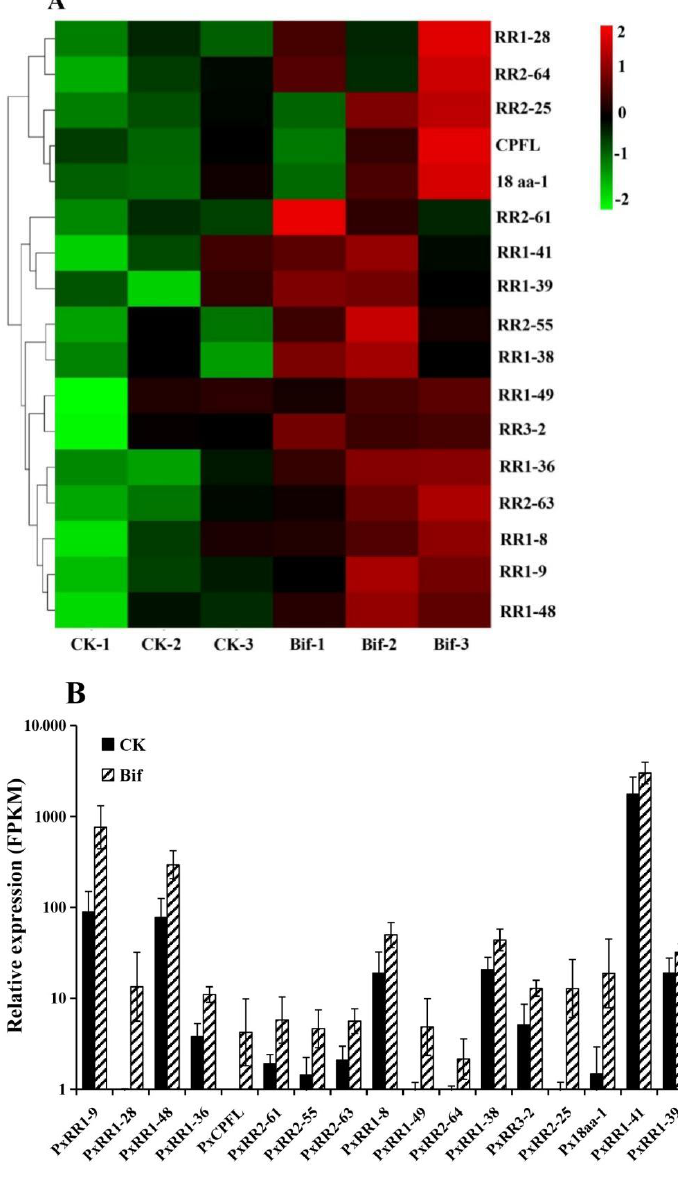
Figure 7. The expression levels (FPKM value) of 17 cuticular protein (CP) genes in Plutella xylostella treated with bifenazate at concentrations of LC 30 . ( A ) Heatmap of 17 CPs expression levels. X -axis: sample name, Y -axis: CPs. The colors indicated the expression levels of CPs, and red indicated high expression and green indicated low expression. ( B ) Histogram analysis of 17 CPs expression levels.